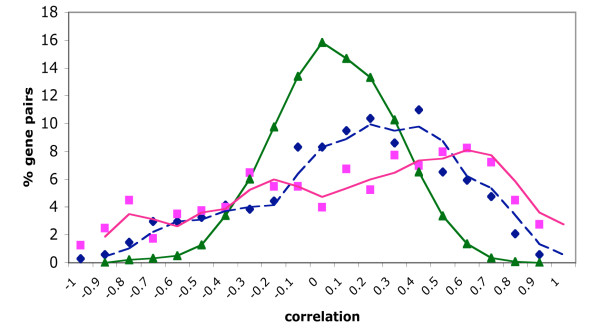
Expression correlations between and within experiments. Frequency distribution of Pearson's intragene correlations for probesets expression profiles of Zhang et al. [17] and Su et al. [47] data. Correlations were calculated for olfactory epithelium, vomeronasal organ, lung, heart, testis, muscle and cerebellum. Dashed (blue) line with diamonds represents the correlation values between 216 OR genes in Zhang et al. [17] and Su et al. [47] data. Solid (pink) line with squares within 402 probesets pairs from Zhang et al. [17], each pair representing the same OR in the coding region and in the 3' UTR. Solid (green) line with triangles for a set of 1000 randomly selected gene pairs probesets from Su et al. [47]. The first two lines were smoothed applying a moving average every 2 points. The first two correlation groups were not significantly different according to Wilcoxon test (p = 0.55), while these two differed from the third (Wilcoxon test, p < 0.0001).